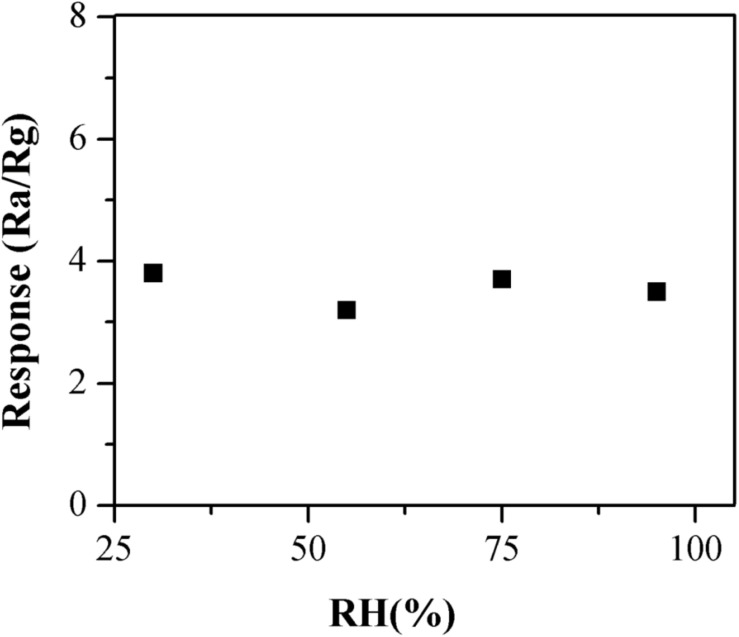
The moisture resistance of the α-Fe2O3 sensor under different humidity conditions (RH = 30, 55, 75, and 95%).